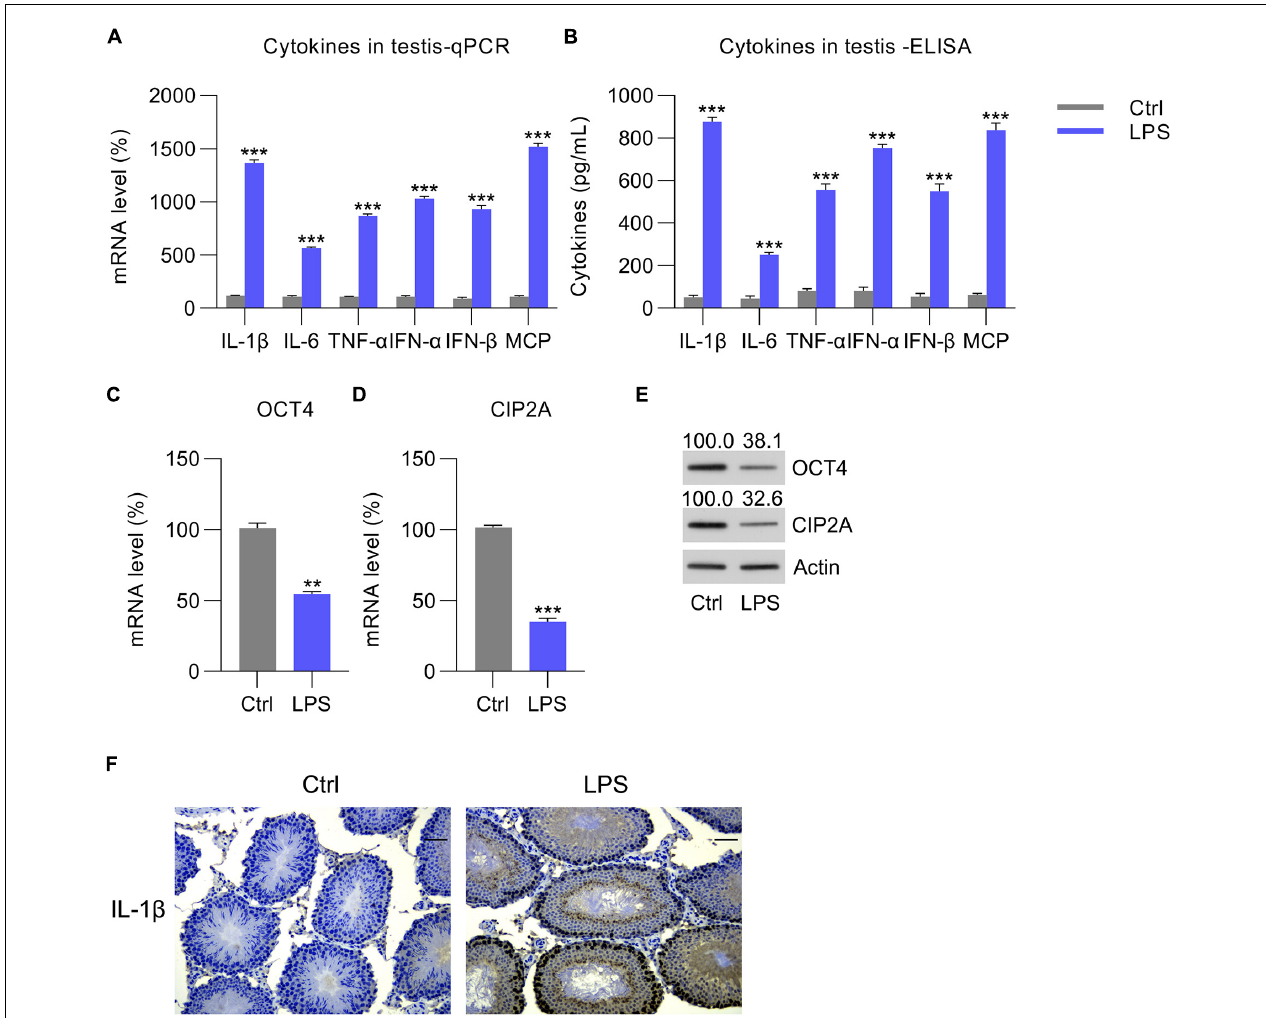
FIGURE 1 | LPS-induced cytokine expression in mouse testes. Overall, 50 mg/kg of pentobarbital sodium was used to anesthetize mice for the subsequent procedure to expose the testes. The testes of the experimental mice were injected with LPS, whereas those of the control animals received PBS. At 12 h post-injection, each testis was homogenized, and the homogenate was tested to determine the (A) mRNA and (B) protein levels of IL-1 β , IL-6, TNF- α , MCP-1, IFN- α , and IFN- β by RT-qPCR and ELISA, respectively. (C,D) The mRNA and (E) protein levels of OCT4 and CIP2A in the testicular homogenate are shown. (F) IHC